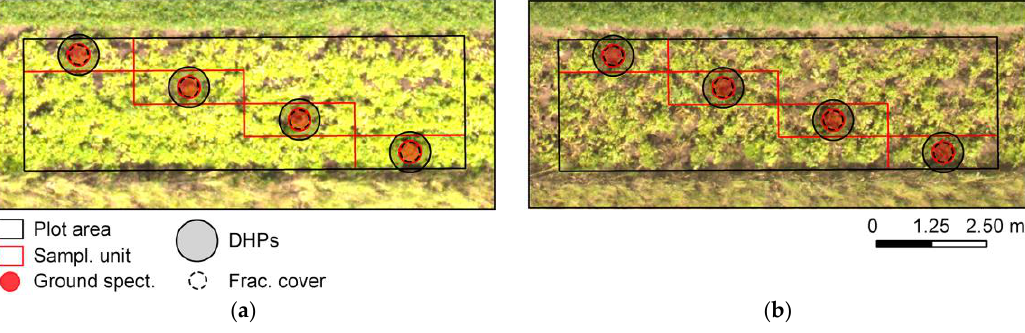
Figure 2. Sampling scheme at plot level represented over RGB orthomosaic for one plot cultivated with the non-mixed treatment ( a ) and other planted with mixed varieties ( b ), on the last acquisition date (31 July 2015). Transparent red circles represent ground-based spectrometer footprint (i.e., measurement area at the top of the canopy) while red rectangles indicate sampling units, in which chlorophyll measurements were made (as described in Section 2.5). Digital hemispherical photographs (DHPs) were taken pointing to the center of the sampling units, and the area sampled by pictures is indicated using transparent black circles (as described in Section 2.6). Small circles indicated by dashed black lines correspond to the area considered to derive fractional vegetation cover from DHPs (as described in Section 2.6).